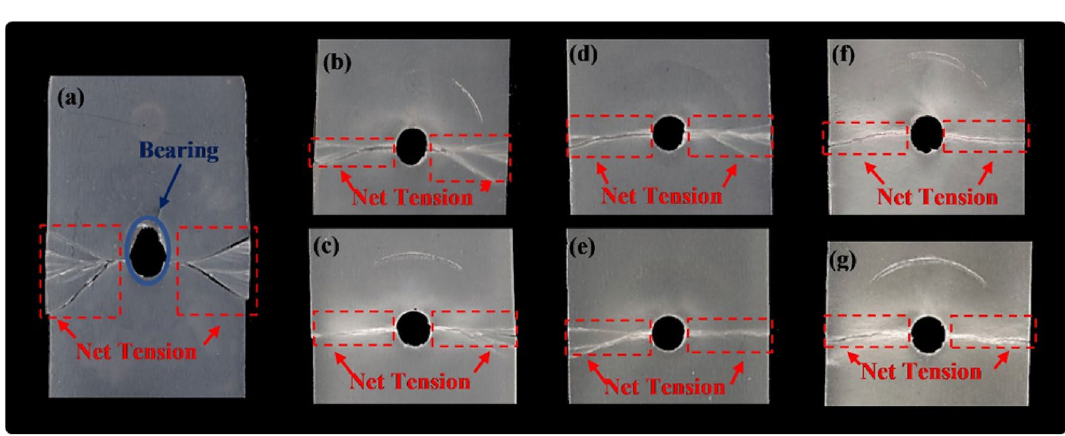
Figure 13. Failure morphologies of specimens tested in bearing in wet condition; ( a ) WB00, ( b ) WB1012, ( c ) WB1024, ( d ) WB2012, ( e ) WB2024, ( f ) WB3012, and ( g )